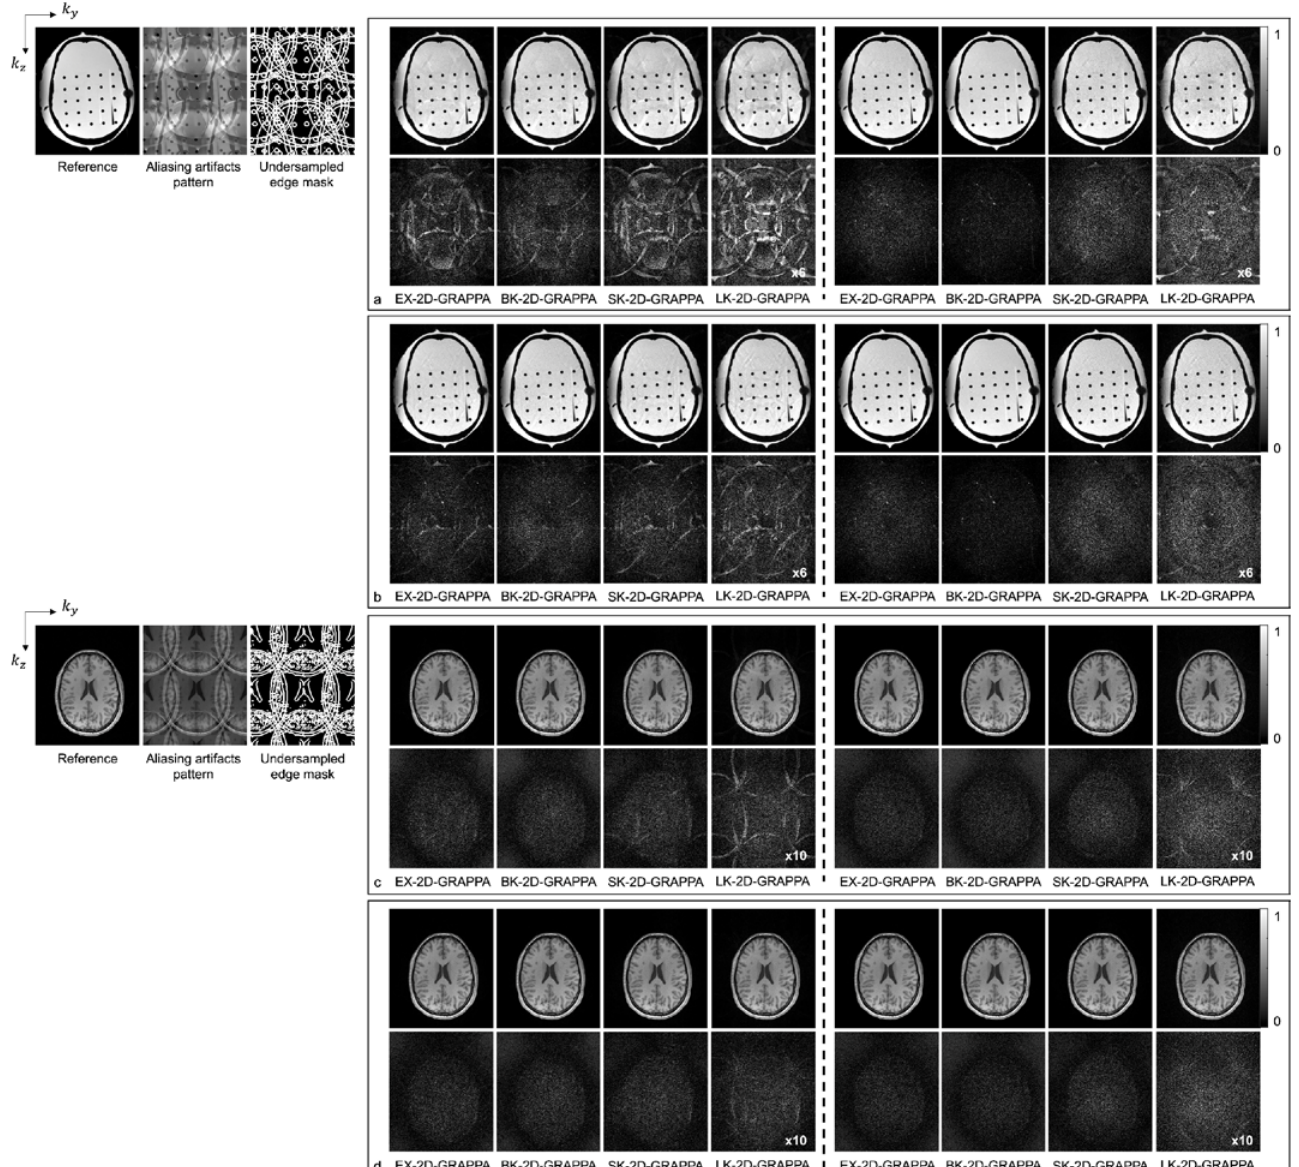
Figure 6. The reconstructed images of acquired anthropomorphic skull phantom ( a , b ) and human brain ( c , d ) data with 24 × 24 k-space reference lines and AF = 4 (2 × 2). The k-space reference lines were ( a , c ) excluded and ( b , d ) included at the end of the reconstruction. Columns 1–4: basis kernel. Columns 5–8: expanded kernel.